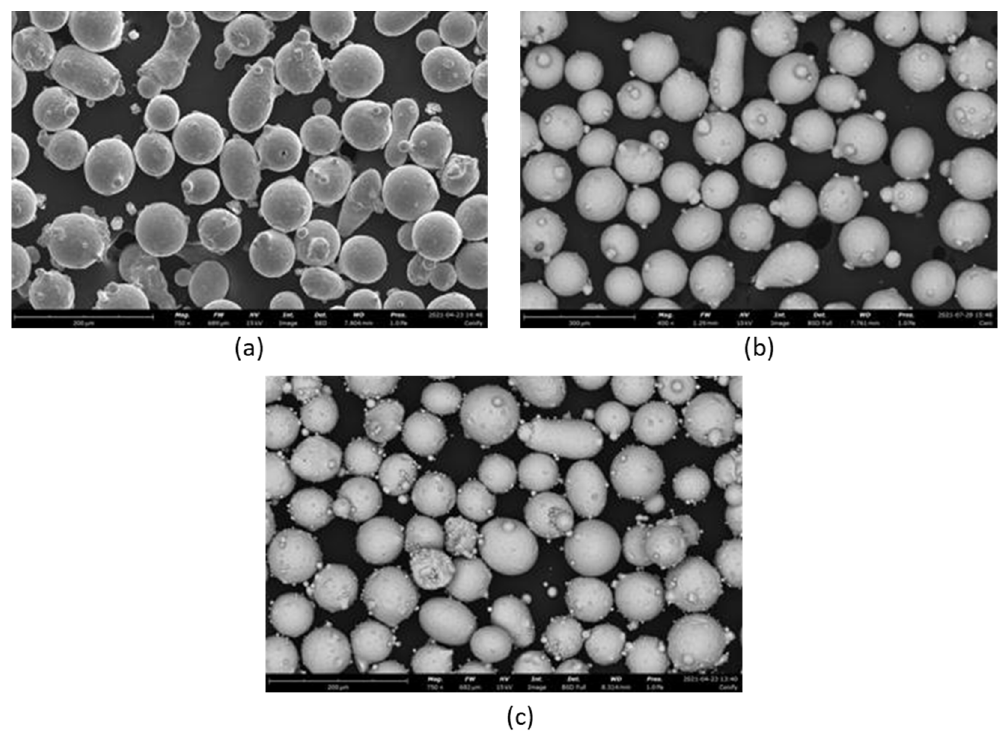
Figure 3. Backscattered electron micrographs of ( a ) Oerlikon (scale at 200 μ m, magnitude 750×), ( b ) ( b ) GKN Additive (scale at 300 µ m, magnitude 400 × ), and ( c ) Atomizing AM (scale at 200 µ m, GKN Additive (scale at 300 μ m, magnitude 400×), and ( c ) Atomizing AM (scale at 200 μ m, magnitude 750 × ) metal magnitude 750×) metal powders.